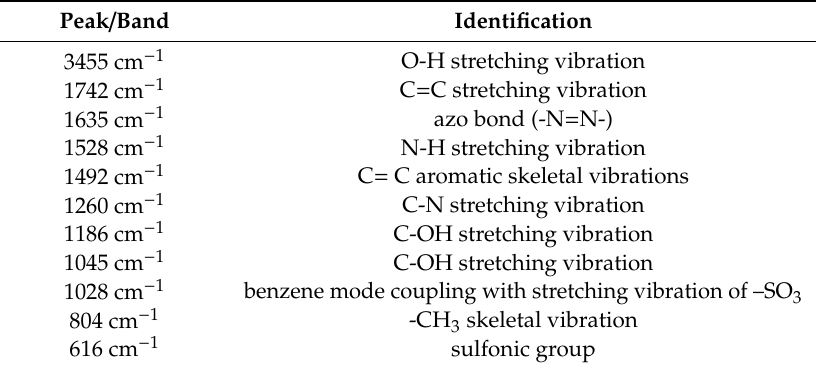
Figure 9. FTIR spectra: ( a ) RB5 powder before degradation selection. ( b , c ) Mn-Al-Fe and Mn-Al-Co powders after degradation, respectively. Table 1. FTIR peaks/bands identification [42–46].